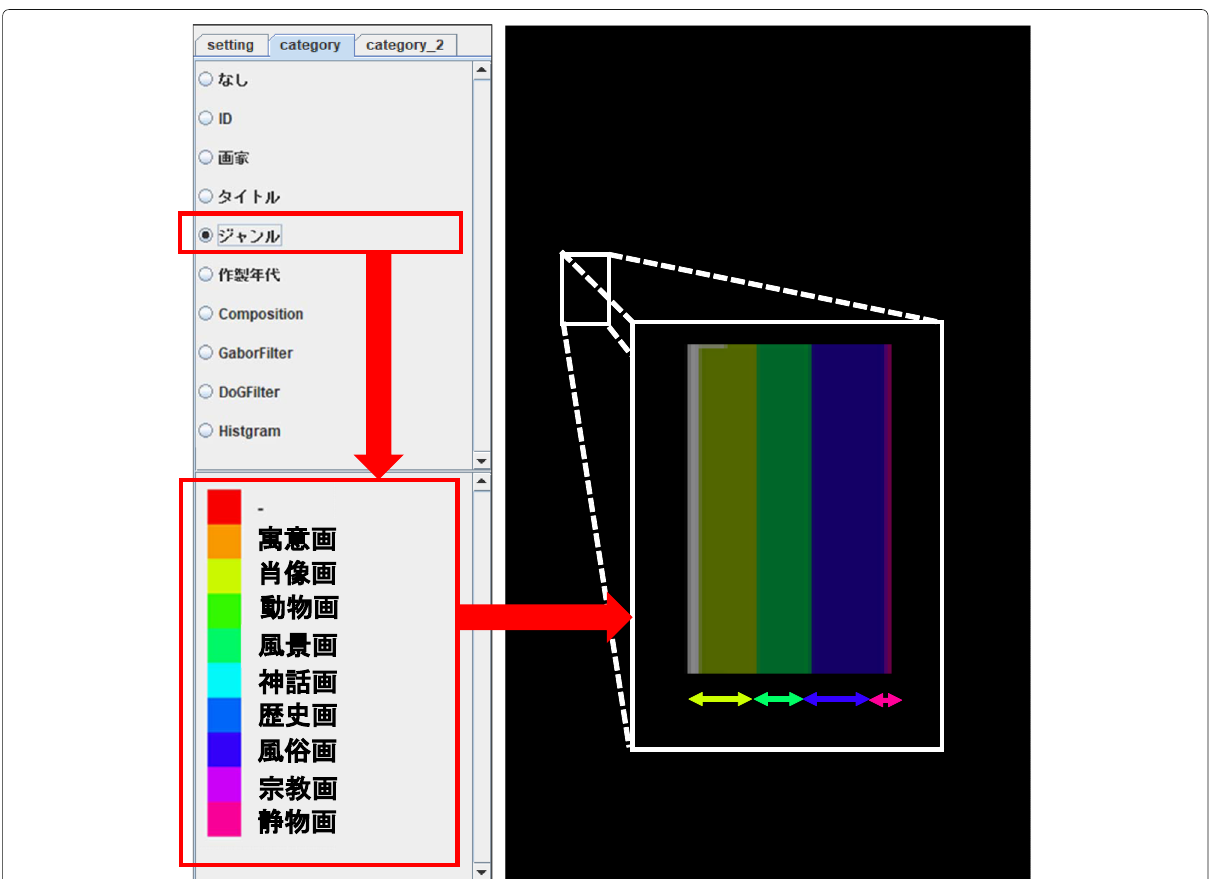
Fig. 3 Categorical variable selection by radio buttons. The color palette displays a list of colors and corresponding categorical values. Component bar charts visualize image feature